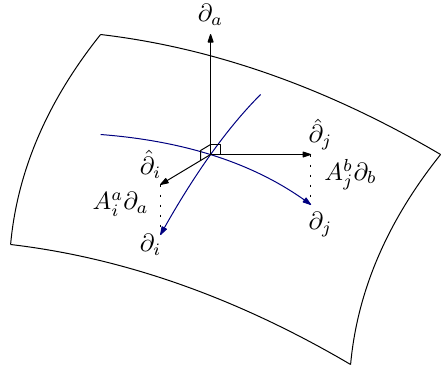
Figure 2. Local geometry of the 2 + ( d − 1)